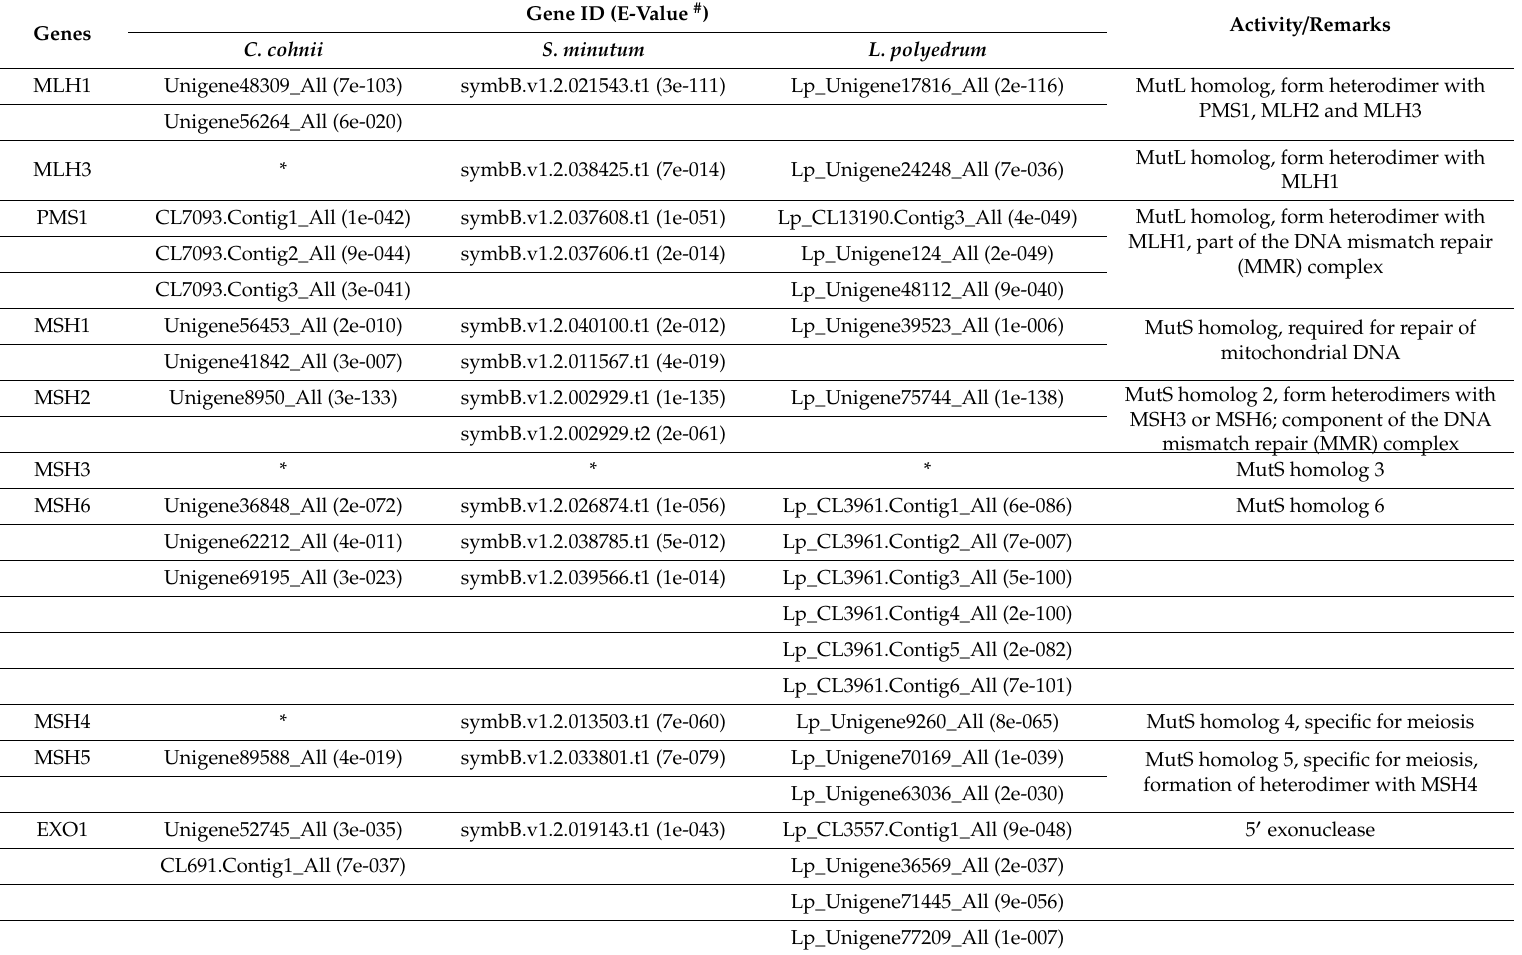
Table 5. Predicted dinoflagellate orthologues in DNA mismatch